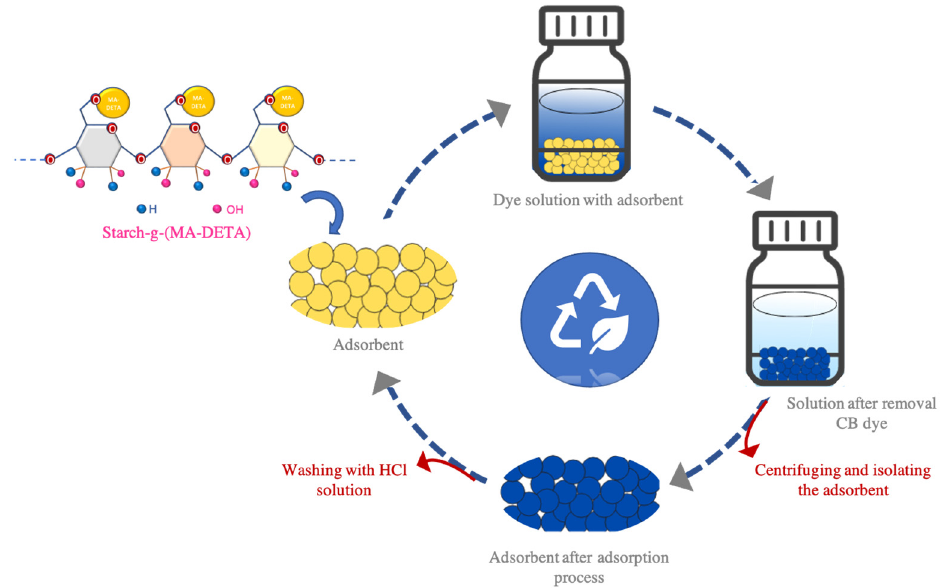
Figure 16. Example of the adsorption process using St-g-(MA-DETA).